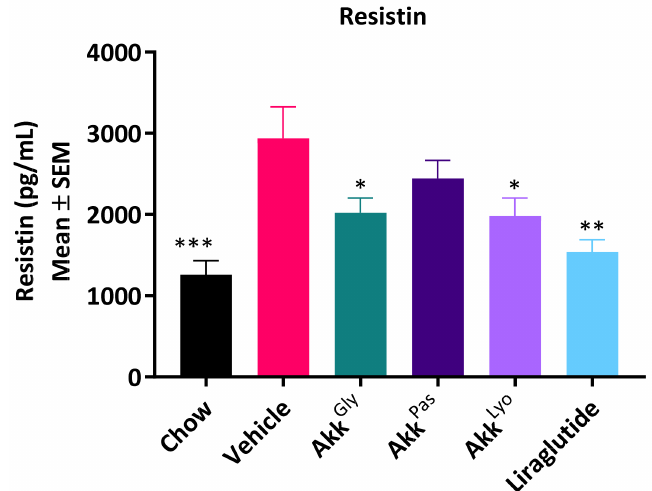
Figure 7. Akkermansia sp. DSM33449 modulates resistin levels in a DIO mouse model ( n = 10). Serum resistin levels of animals fed on a standard chow (chow) or high-fat diet (HFD) and treated by oral gavage with a solution of vehicle (PBS + Glycerol) or Akkermansia sp. DSM 33459 frozen (Akk Gly ) or pasteurized (Akk Pas ) or lyophilized (Akk Lyo ) for 12 weeks. Data are presented as mean ± SEM.